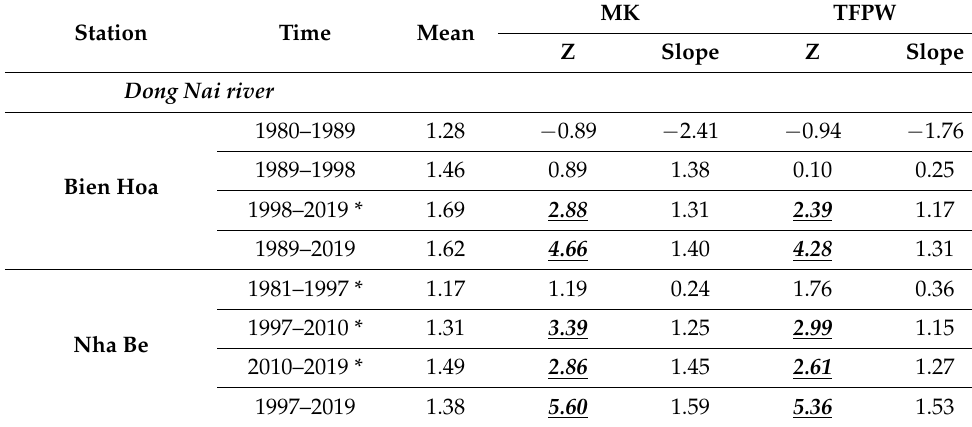
Table 7. Periodic water level trend at H p99%